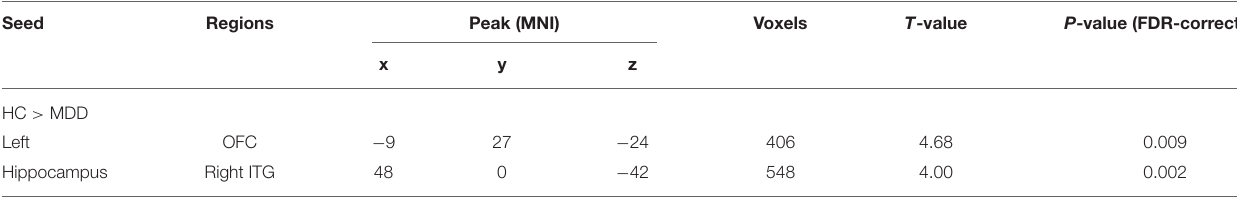
TABLE 2 | Region of abnormal resting-state FC between the hippocampus and regions. Seed Regions Peak (MNI) Voxels T -value P -value (FDR-corrected)